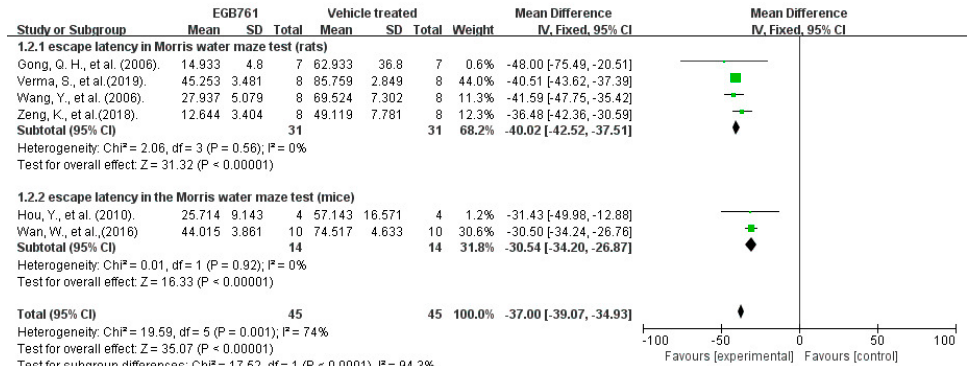
Figure 5. Forest plot for comparison: GBE treatment versus vehicle treatment. Outcome: escape la- tency in the probe test of MWM. The square area represents the weight assigned to the study in the meta-analysis. The horizontal line represents the 95% confidence interval.